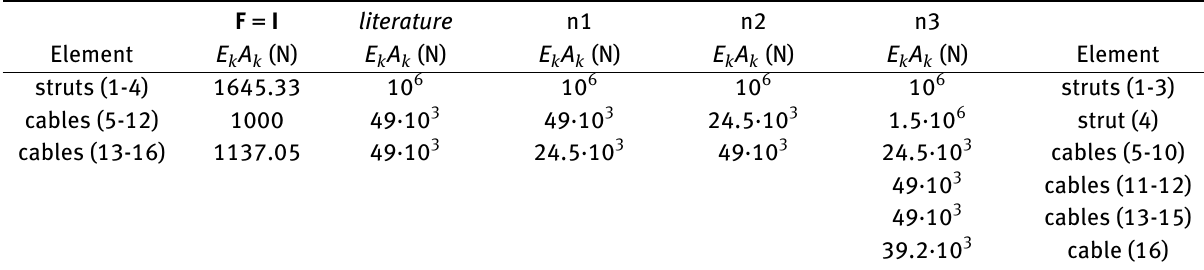
Table 1: Axial stiffness of the elements of the Quadruplex F = I